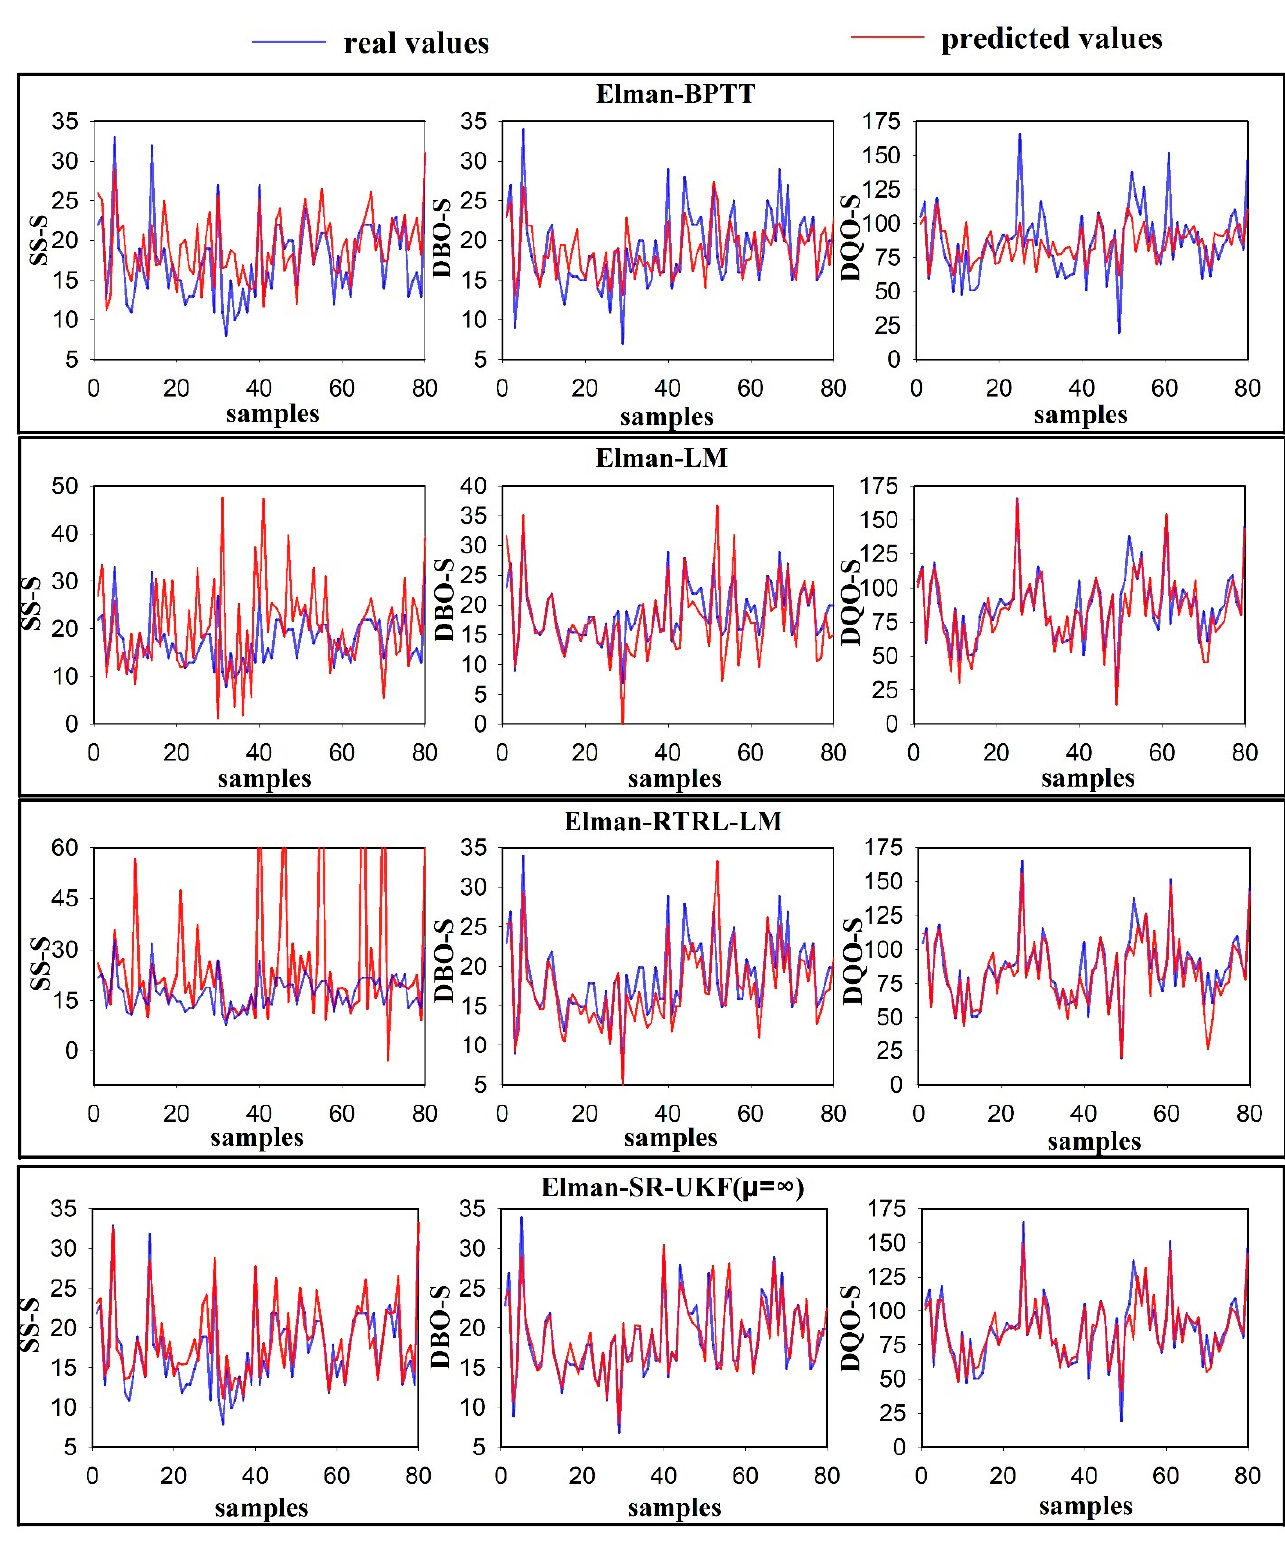
Figure 4. Prediction profiles of output variables compared with real values. (The first 80 time series data in the testing dataset).